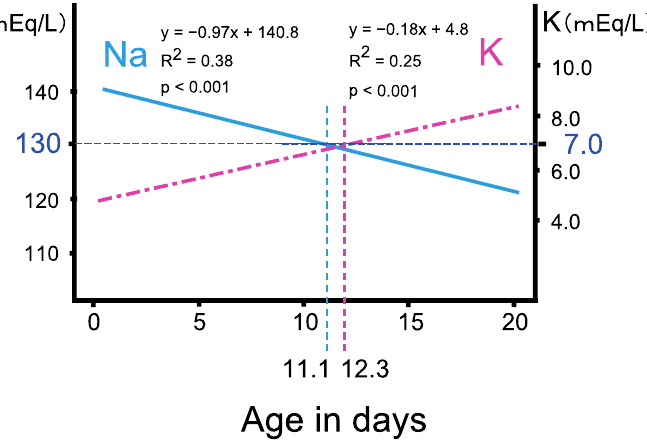
Figure 3. Clinical features of serum sodium (Na) and potassium (K) levels in 21OHD neonates. Retrospective analysis of the NBS in Tokyo revealed that, in classical 21OHD patients, the serum Na and K levels linearly deteriorated with age in days, and the age when the regression lines reached Na < 130 mEq/L, K > 7 mEq/L approximately coincided at 11.1 and 12.3 days, respectively. (Modified from Gau et al., 2020 [13]).